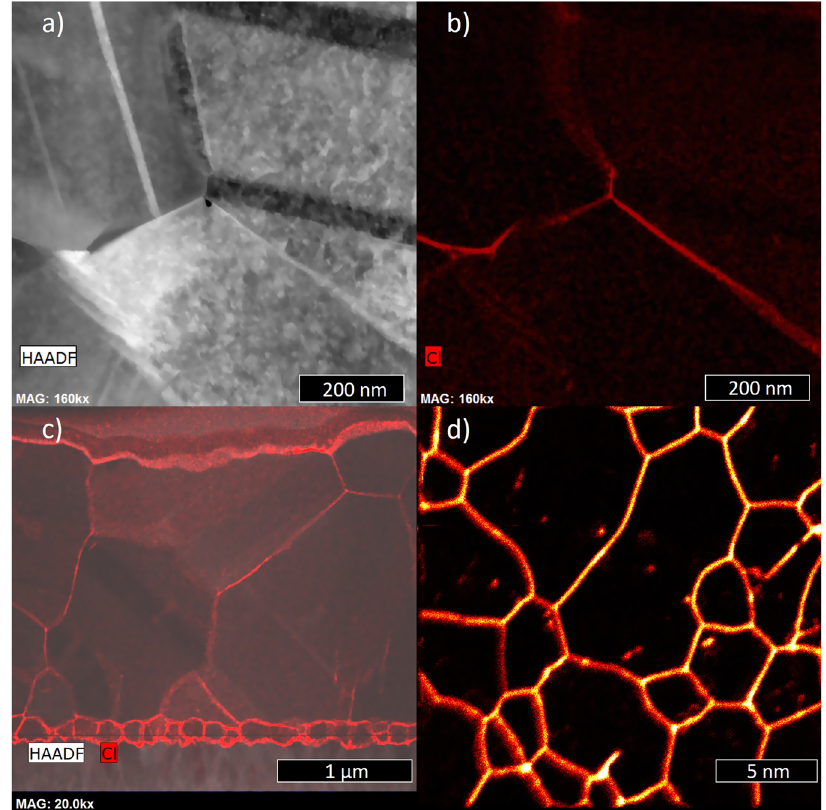
Fig. 1 TEM/EDX/NanoSIMS images of Cl-treated CdTe. a TEM image of activated CdTe showing grain boundary/interior structures. b Same region as in a with EDX mapping post-treatment CdTe with Cl shown in red; the Cl concentration is high in the grain boundaries compared to bulk. c Low-resolution TEM image of treated CdTe with EDX mapping of Cl atoms shown to have heavily segregated to the grain boundaries and interfaces. d 35 Cl − NanoSIMS signal distribution on the back surface of the CdTe absorber showing Cl segregation at grain boundaries after CdCl 2